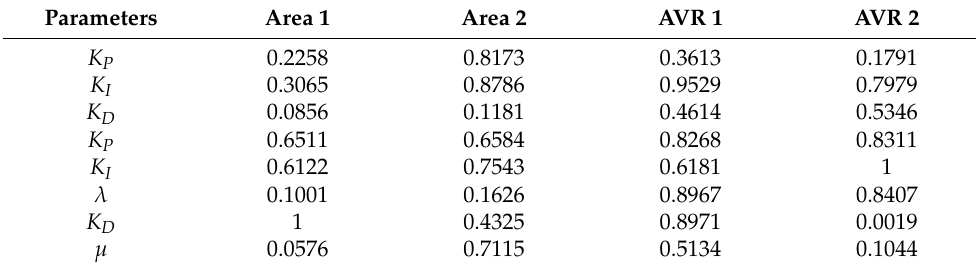
Table 10. SMES-optimized parameters for SMES-SMES